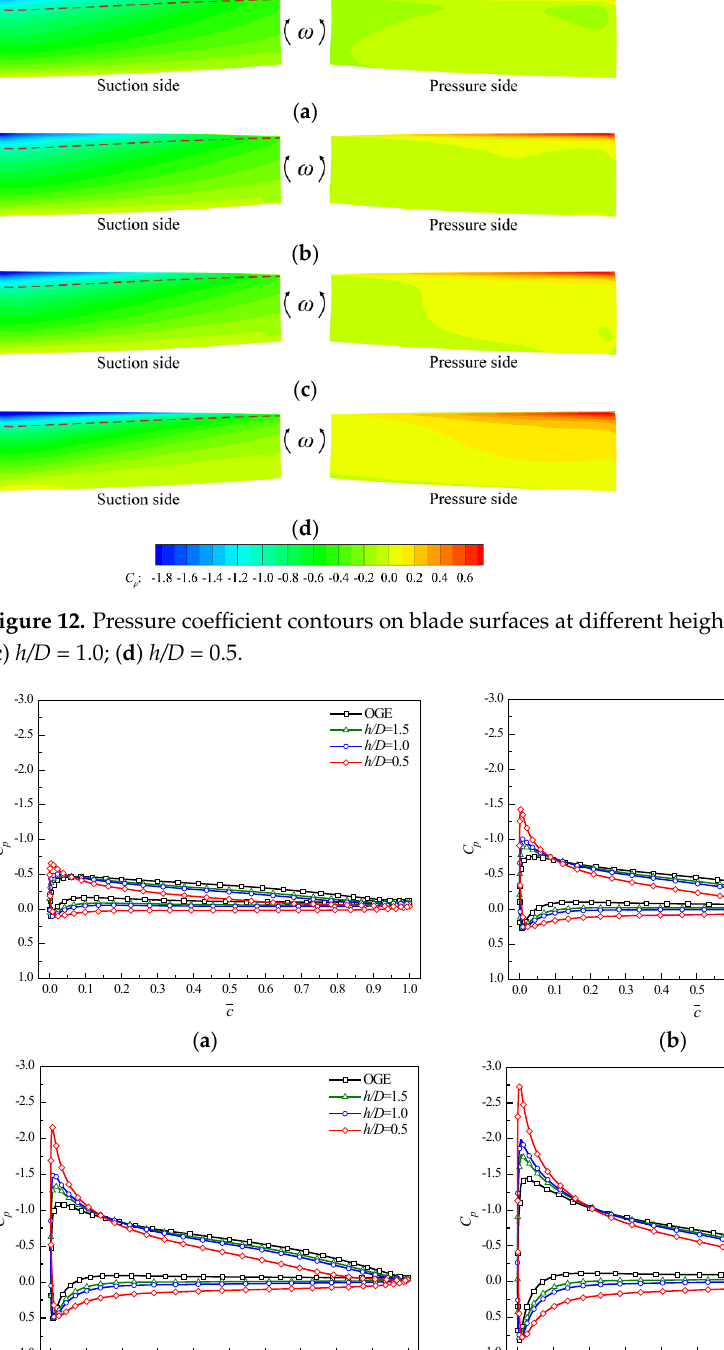
Figure 11. Variation in ducted fan performance with height: ( a ) thrust ratios; ( b ) torque and power loading ratios.